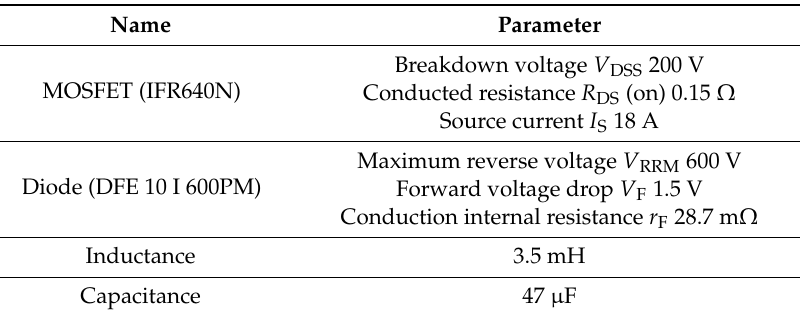
Figure 12. Details of PI controller and feedback controller modules. Table 1. Device parameters in the simulation model.